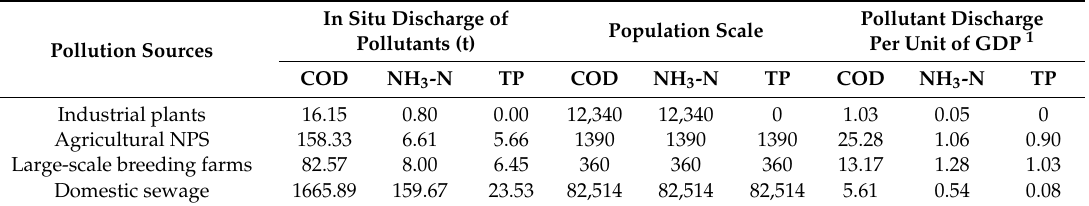
Table 6. The partial indicators of alternatives at the decision-making level, with respect to the elements of the criteria level